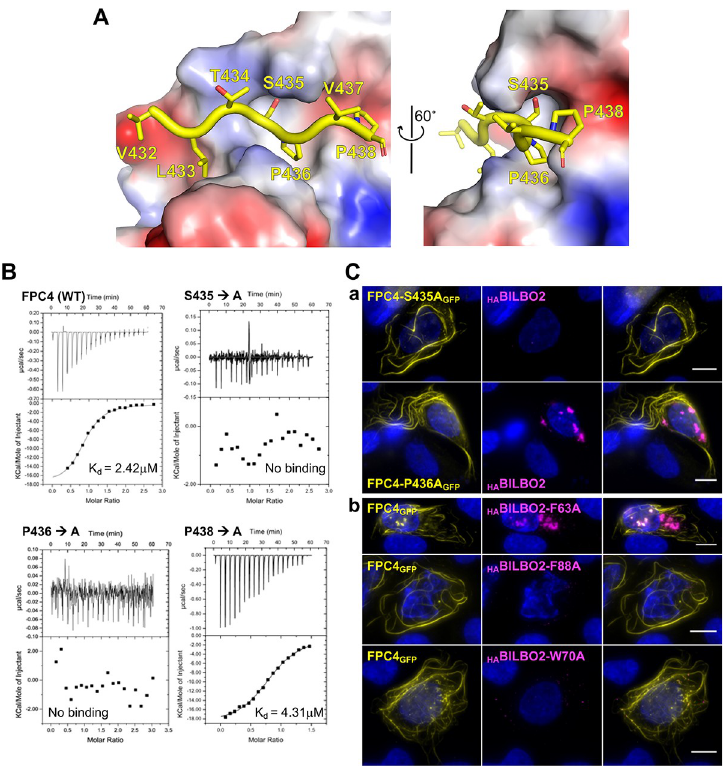
Fig 8. Identification of key residues involved in the BILBO2-FPC4 interaction. A. Interaction between FPC4-B1BD and BILBO2-NTD. FPC4 residues are depicted as sticks in yellow, whereas BILBO2-NTD is shown as an electrostatic surface plot. B. ITC experiments using purified BILBO2-NTD and wild-type (WT) and mutants of FPC4-B1BD. C. Co-immunolocalization of HA BILBO2 (magenta) and of mutated forms of FPC4 GFP (yellow) in U-2 OS cells (a). Co- immunolocalization of FPC4 GFP (yellow) and mutated forms of HA BILBO2 (magenta) (b). Scale bars, 10 μ m.